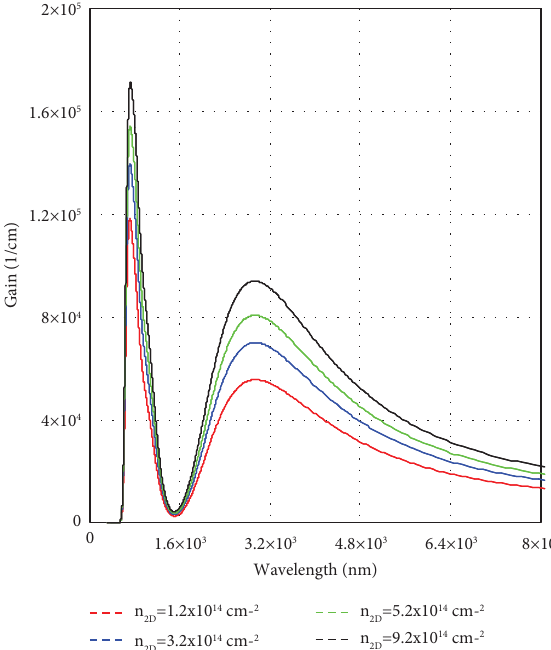
Figure 2: Te doped TlBr/BrCl QD gain at diferent carrier densities.